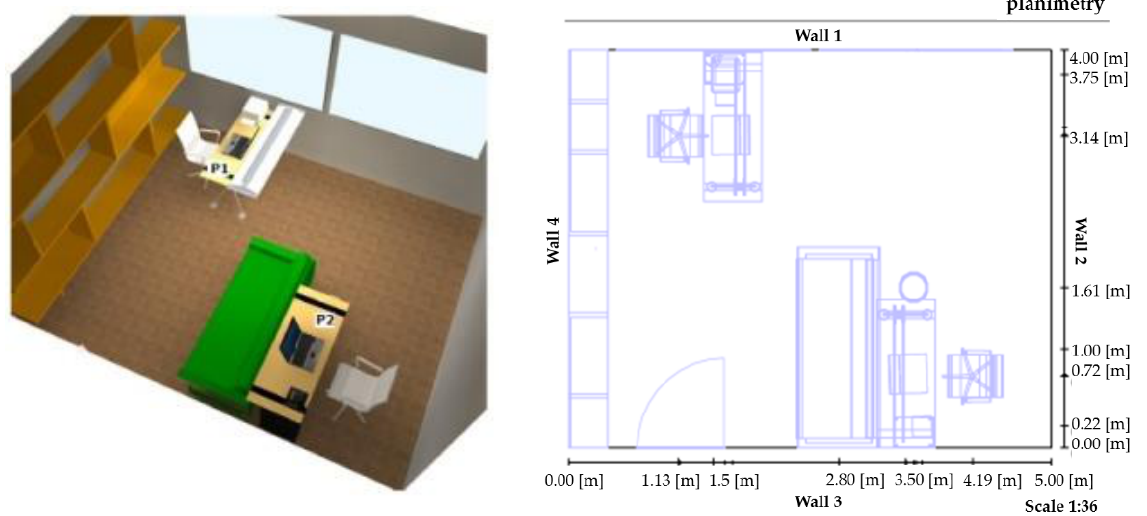
Figure 6. Top view and planimetry of the room (simulated environment).